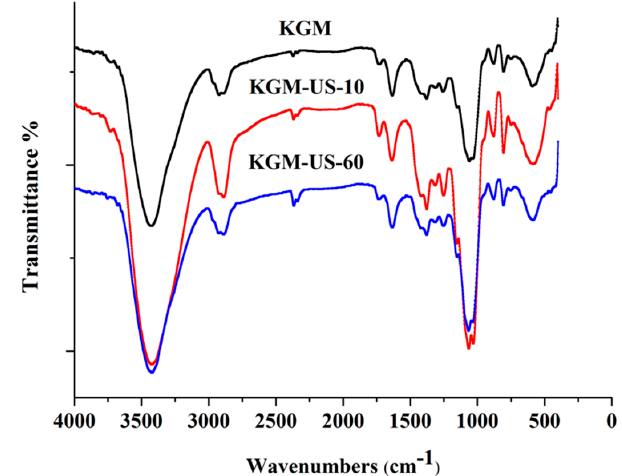
Figure 4. Fourier-transform infrared (FTIR) spectra of original KGM and US-treated KGM (KGM-US-10 and KGM-US-60).